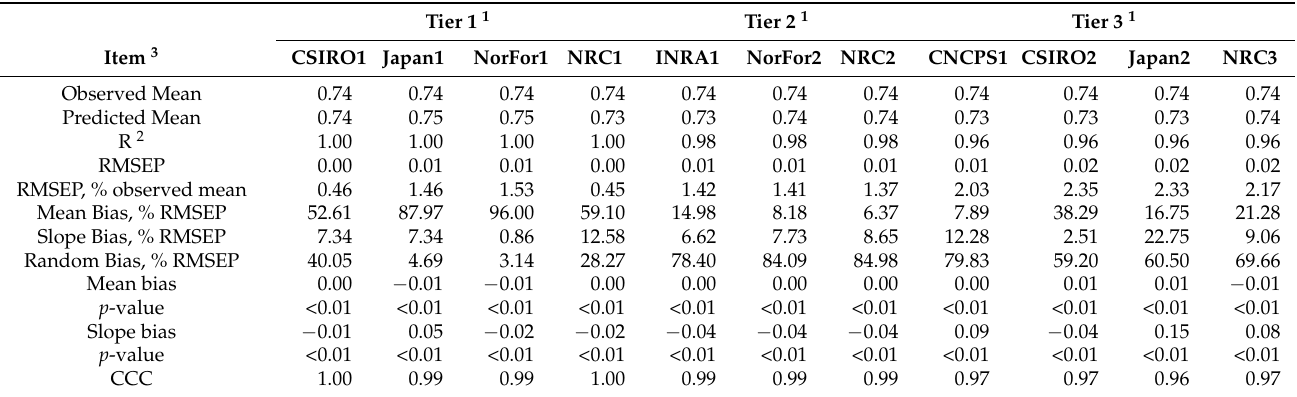
Table 4. Evaluation of precision, accuracy, prediction error, and source of bias of the different milk energy prediction models ( n = 935).